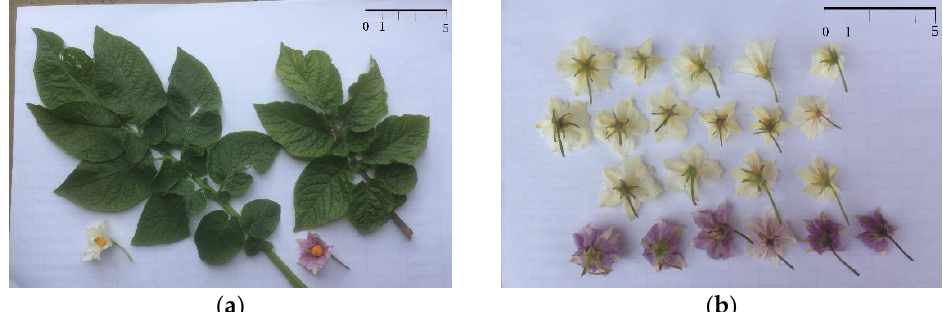
Figure 2. ( a ) Flowers and leaves of parental genotypes 13/11-09 clone (right) and cv. Sudarynya (left); ( b ) flowers of F1 segregants.